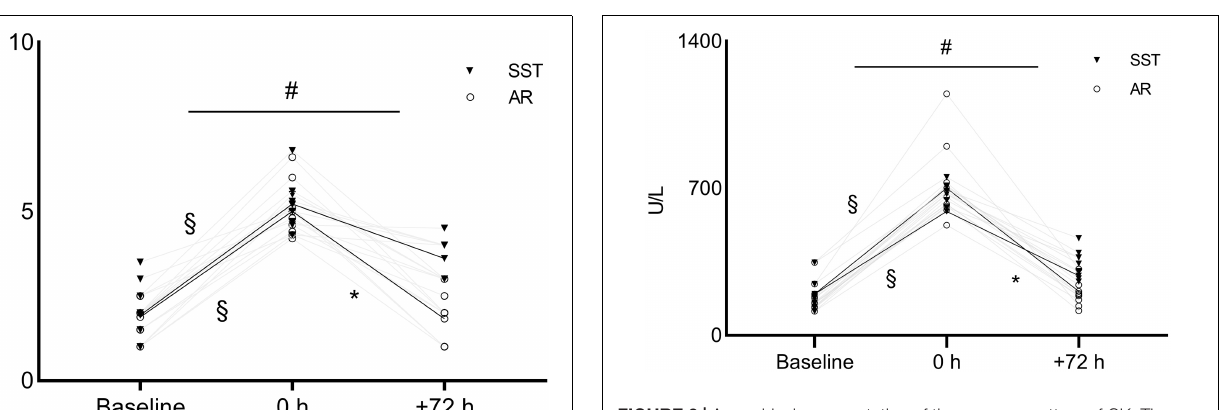
FIGURE 3 | A graphical representation of the recovery pattern of CK. The bold lines identify the means of both SST and AR. # Significant ( P < 0.05) interaction throughout the time points (baseline, 0 h, and +72 h). § Significant ( P < 0.05) difference between 0 h and baseline for SST and AR. *Significant ( P < 0.05) difference between +72 h and 0 h for AR. SST, sport-specific training session; AR, active recovery session; CK, creatine